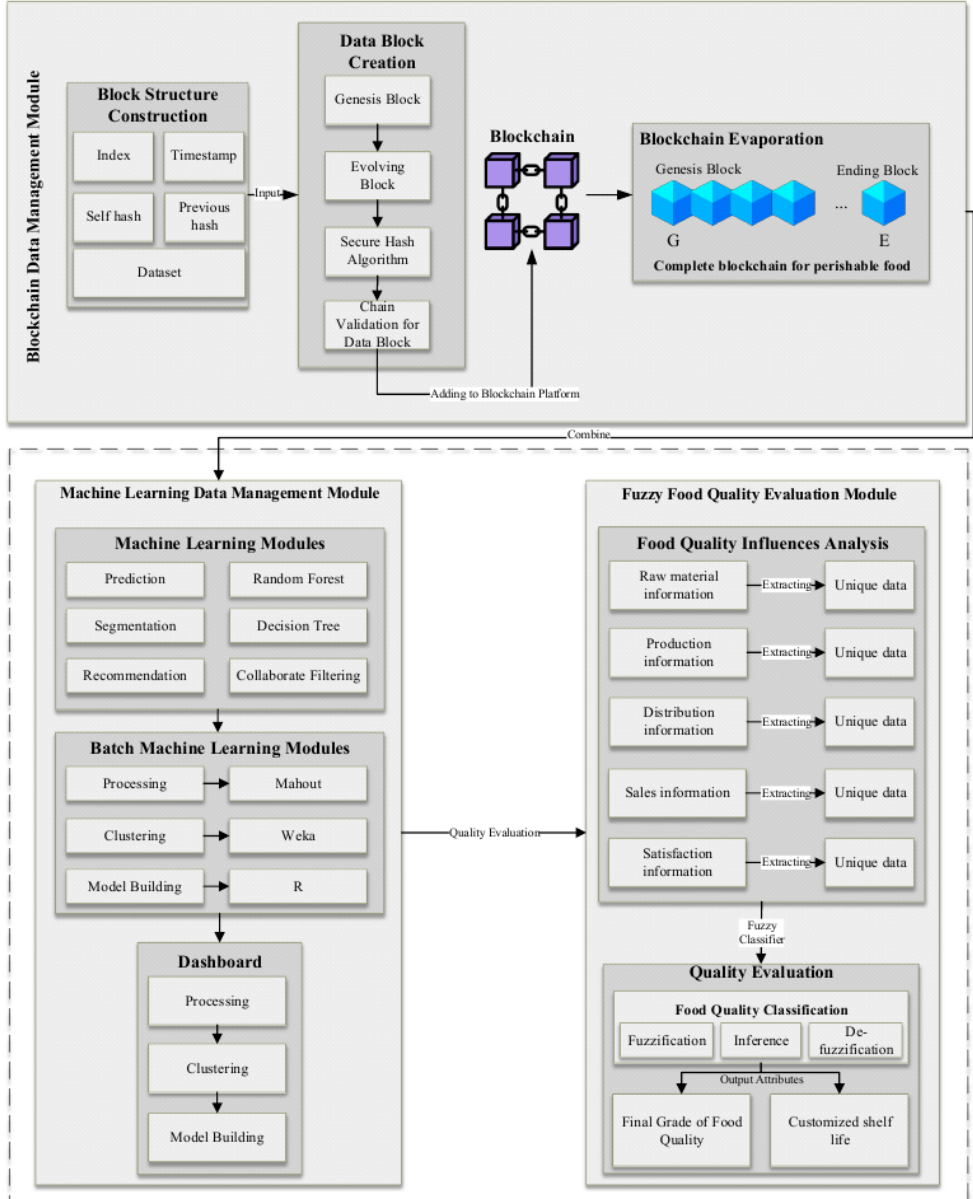
Figure 2. Modular framework of the proposed blockchain machine learning-based food traceability system